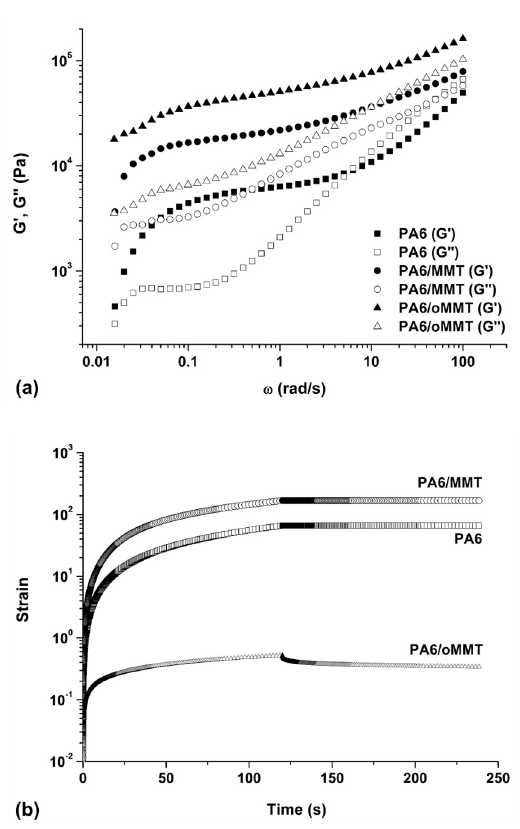
Figure 2. Rheological characterization of the extruded samples, at 250°C: (a) G'(ω) and G''(ω); (b) creep (τ = 1,000 Pa, t = 120 s) and constrained recoil (τ = 0 Pa, t = 120 s).